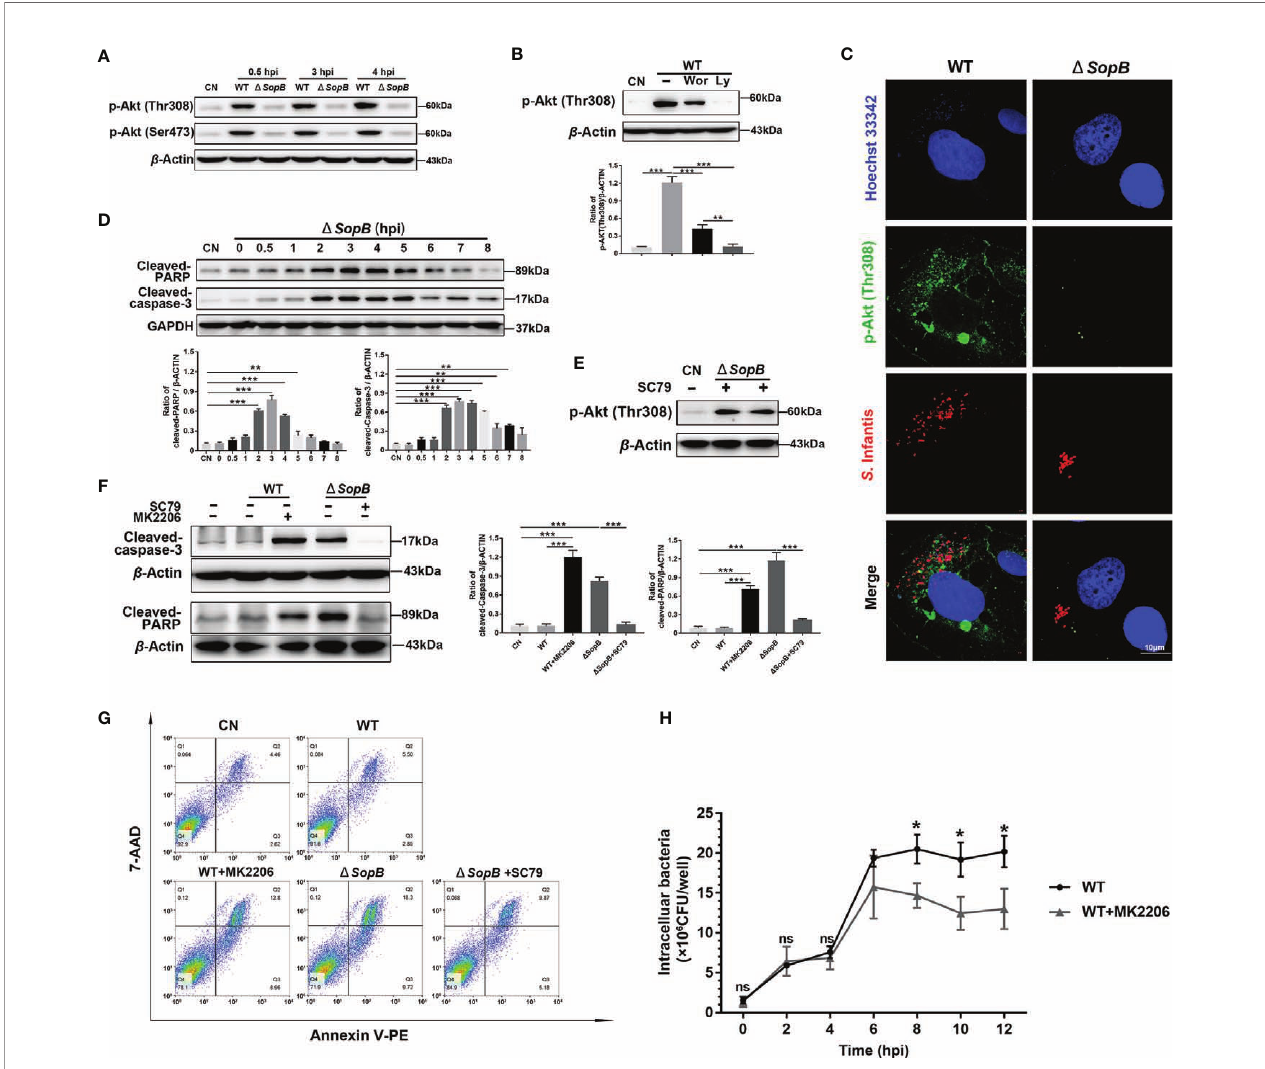
FIGURE 3 | Inhibition of apoptosis by intermittent Akt phosphorylation was mediated by Cytosolic S . Infantis SopB . (A) Western blot analysis of p-Akt (Ser473) and p-Akt (Thr308) protein expression levels after WT S . Infantis or SopB mutant infection at 0.5, 3, and 4 hpi. CN, control. (B) Immunoblotting veri fi ed the repressive effects of Ly294002 (Ly) and Wortmannin (Wor) on p-Akt (Thr308) protein expression levels after infection with WT S . Infantis. CN, control. (C) Immuno fl uorescence staining of p-Akt (Thr308) after infection with WT S . Infantis or the SopB mutant at 4 hpi. Red: S . Infantis. Green: p-Akt (Thr308). Blue: Hoechst 333342. (D) Western blot analysis of Cleaved-caspase-3 and Cleaved-PARP protein expression levels within 8 h after SopB mutant infection. CN, control. (E) Immunoblotting veri fi ed the activation of SC79 on p-Akt (Thr308) protein expression level after SopB mutant infection at 4 hpi. CN, control. (F, G) Apoptosis was evaluated after infection with WT S . Infantis or the SopB mutant at 4 hpi. In the process of bacterial infection, the phosphorylation level of Akt was regulated by the addition of MK2206 or SC79. (F) The protein levels of Cleaved-caspase-3 and Cleaved-PARP were analyzed using Western blotting. (G) The proportion of apoptotic cells was detected using fl ow cytometry. (H) Detection of intracellular bacterial load using the gentamicin protection assay without (total intracellular bacteria, black curve) or with (total intracellular bacteria, gray curve) MK2206. ns, no signi fi cant difference. Data were presented as the mean ± SEM from three independent experiments (n = 3). * P < 0.05, ** P < 0.01, *** P <